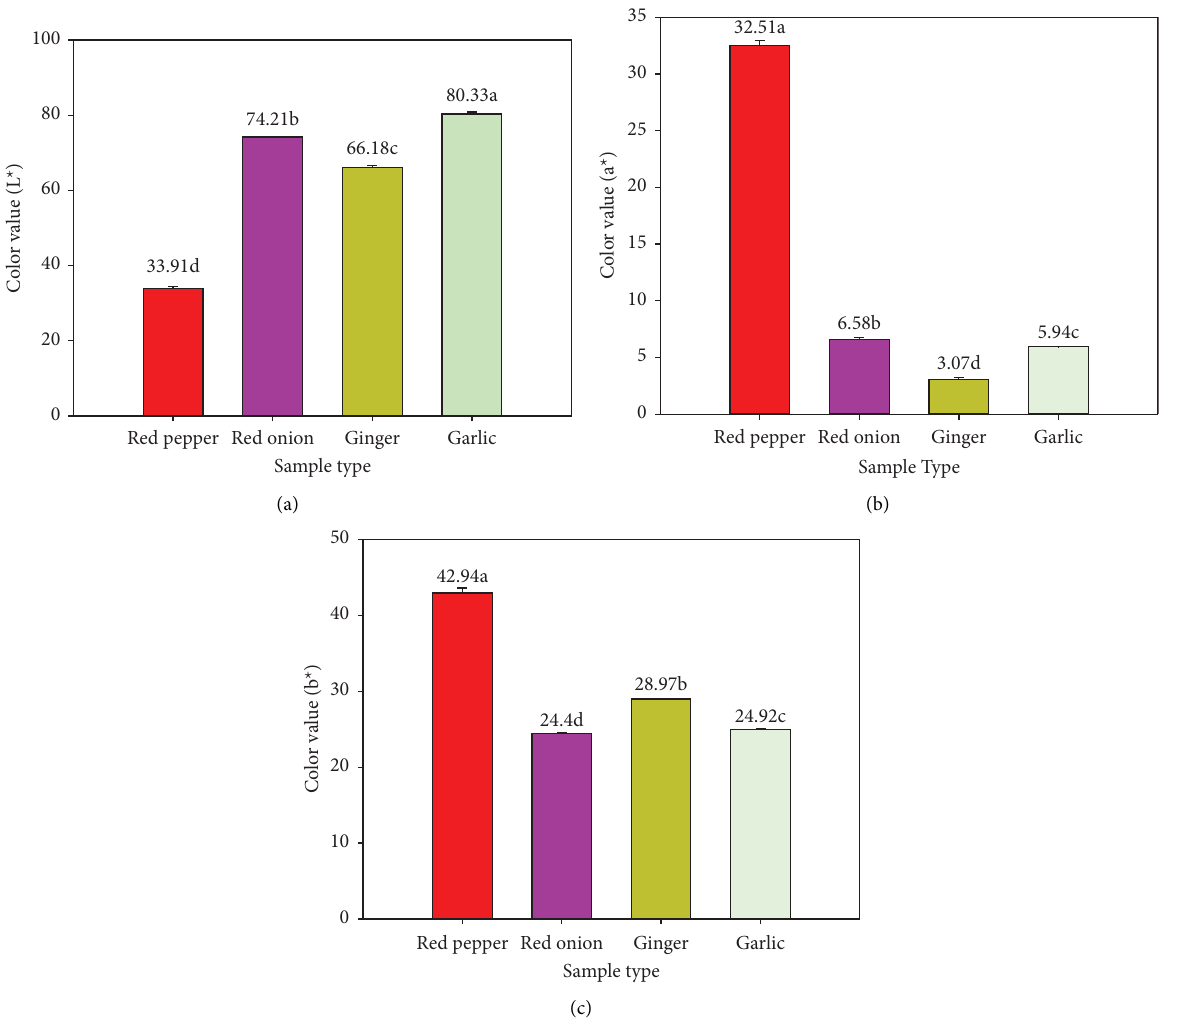
Figure 5: Color values (L ∗ , a ∗ , and b ∗ ) of red pepper, red onion, ginger, and